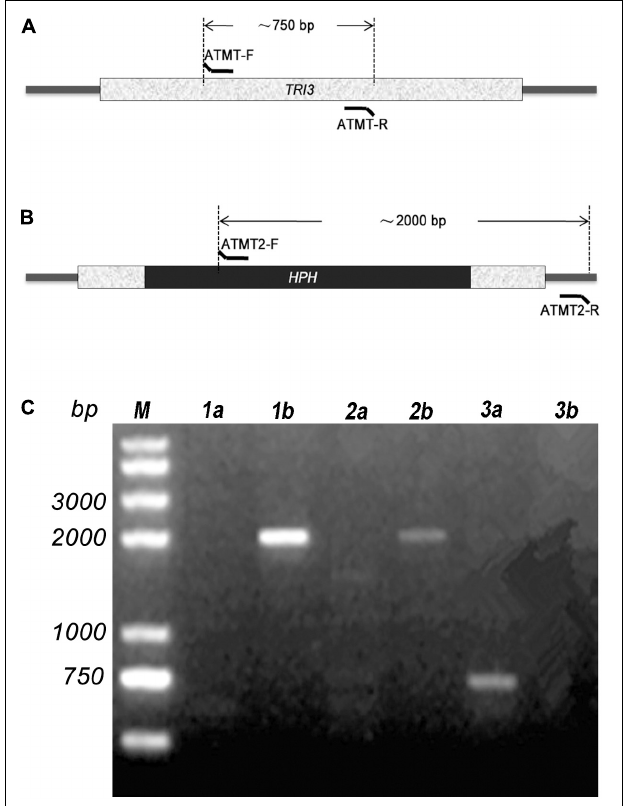
FIGURE 3 | PCR confirmation of insertion of the HPH cassette in TRI3 gene. The relative positions of primers ATMT-F/R (A) and ATMT2-F/R (B) are shown. (C) Two transformants were confirmed by PCR. Primer pair ATMT-F/R was used for lane 1a, 2a, and 3a; while ATMT2-F/R was used for lane 1b, 2b, and 3b. 1a, 1b and 2a, 2b were designated for the two transformants. Wild-type strain was used in 3a and 3b.